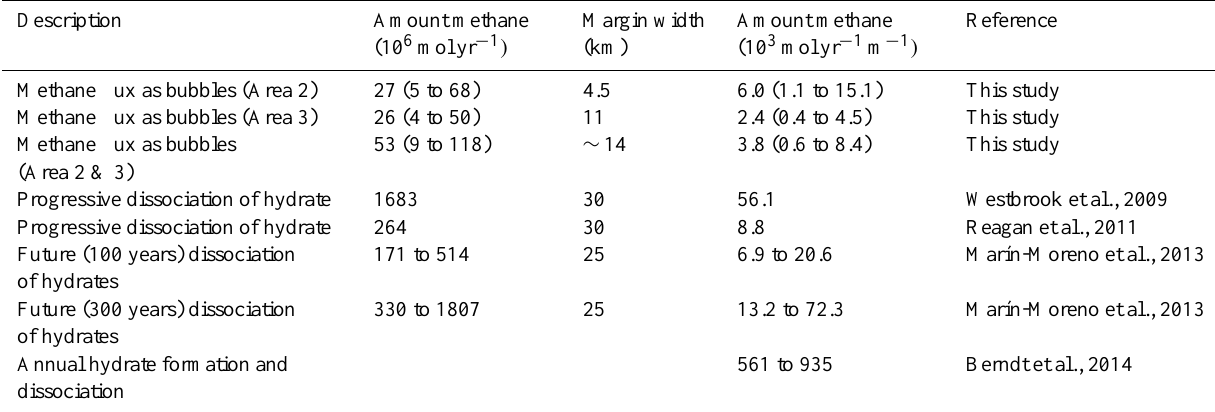
Table 7. Amount of methane either released as bubbles from the seafloor (this study) or susceptible to temperature-induced hydrate dissoci- ation as revealed from